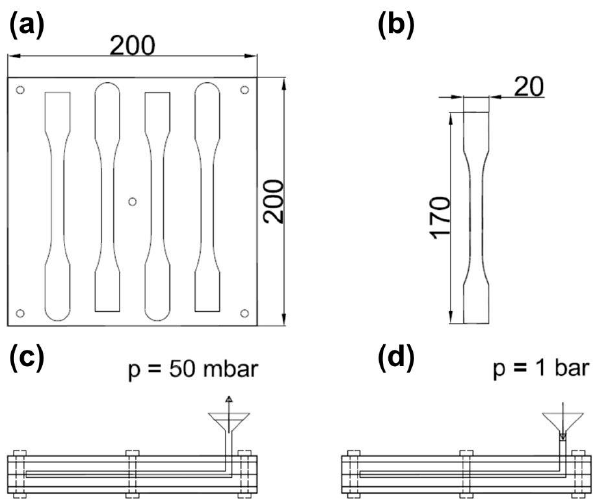
Figure 2. Principle of the vacuum casting technique for tensile specimens: ( a ) Silicone mold for four specimens and ( b ) their dimensions. ( c ) Evacuation of the closed mold with a filled funnel and ( d ) the flow of material inside the mold after ventilation of the vacuum chamber. All measures are given in mm.